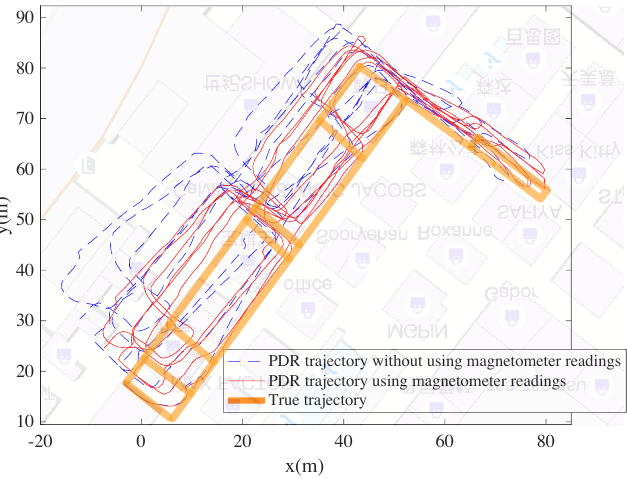
Figure 7. The PDR trajectories with and without magnetometer